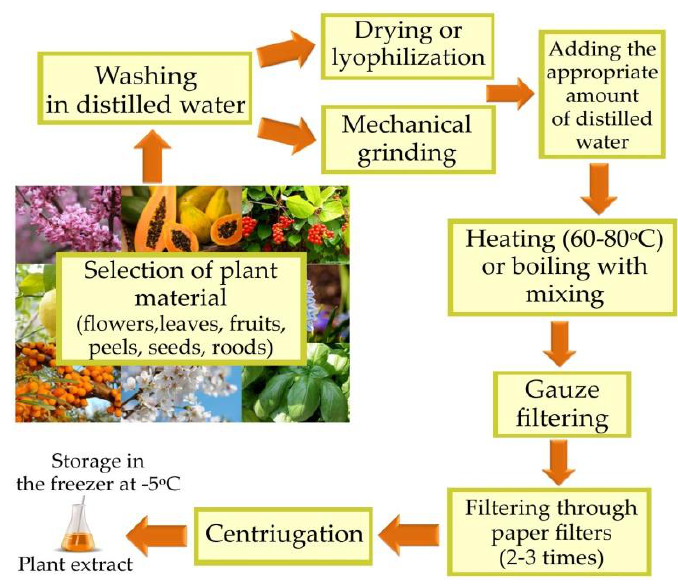
Figure 1. Preparation of plant extract.